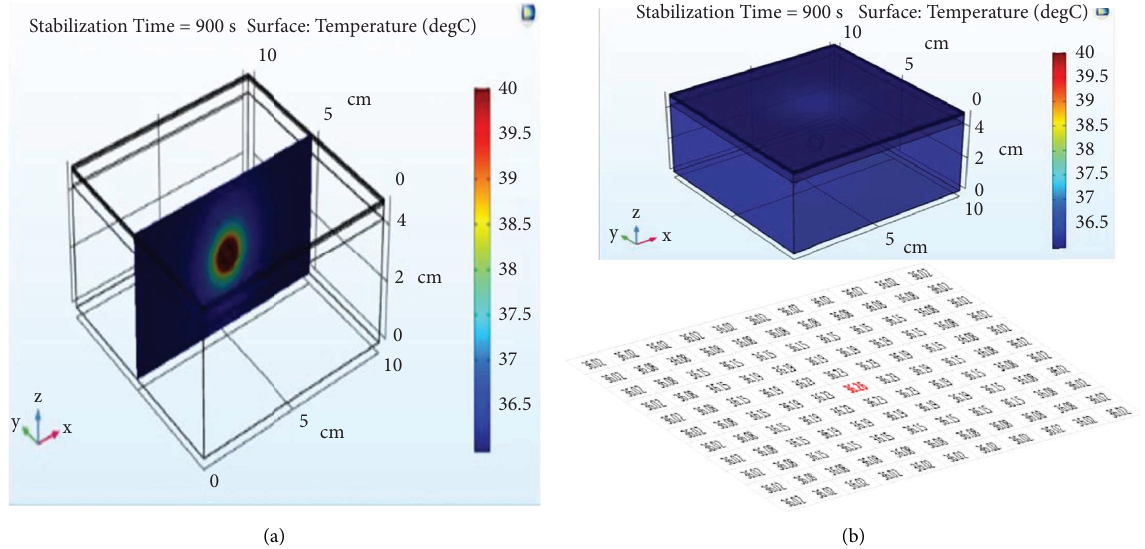
Figure 2: Termal distribution from a 25mm depth tumor (a) Sectional view XZ of 1cm diameter tumor included at 2.5cm in depth and (b) Surface temperature distribution with 1cm tumor located 2.5cm deep, after a stabilization time of